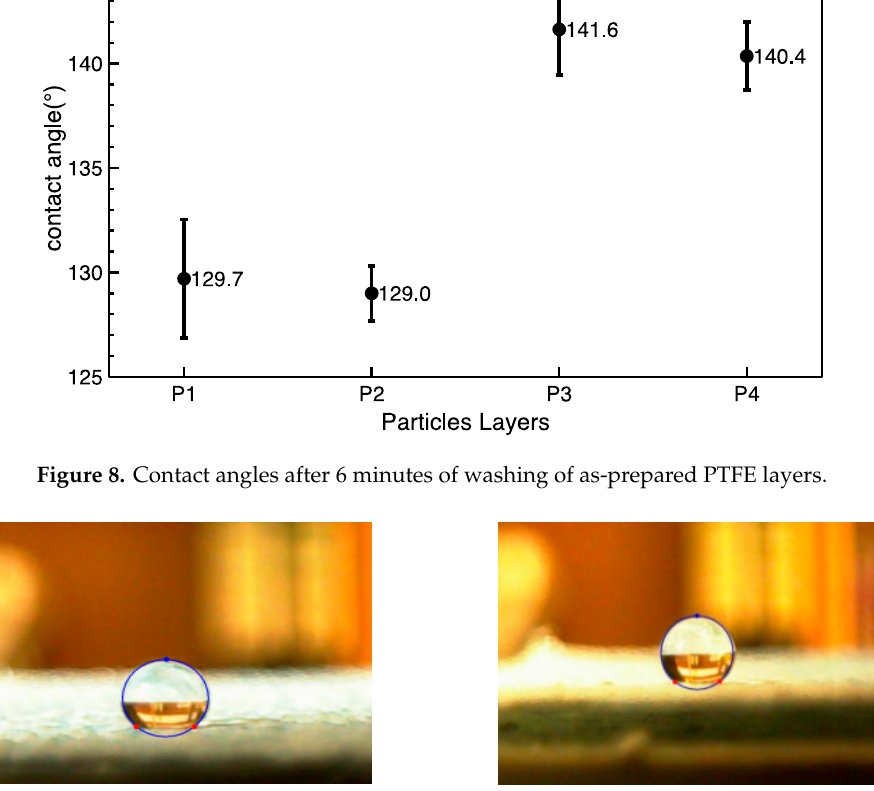
Table 4. Resistivity values of PTFE layers.